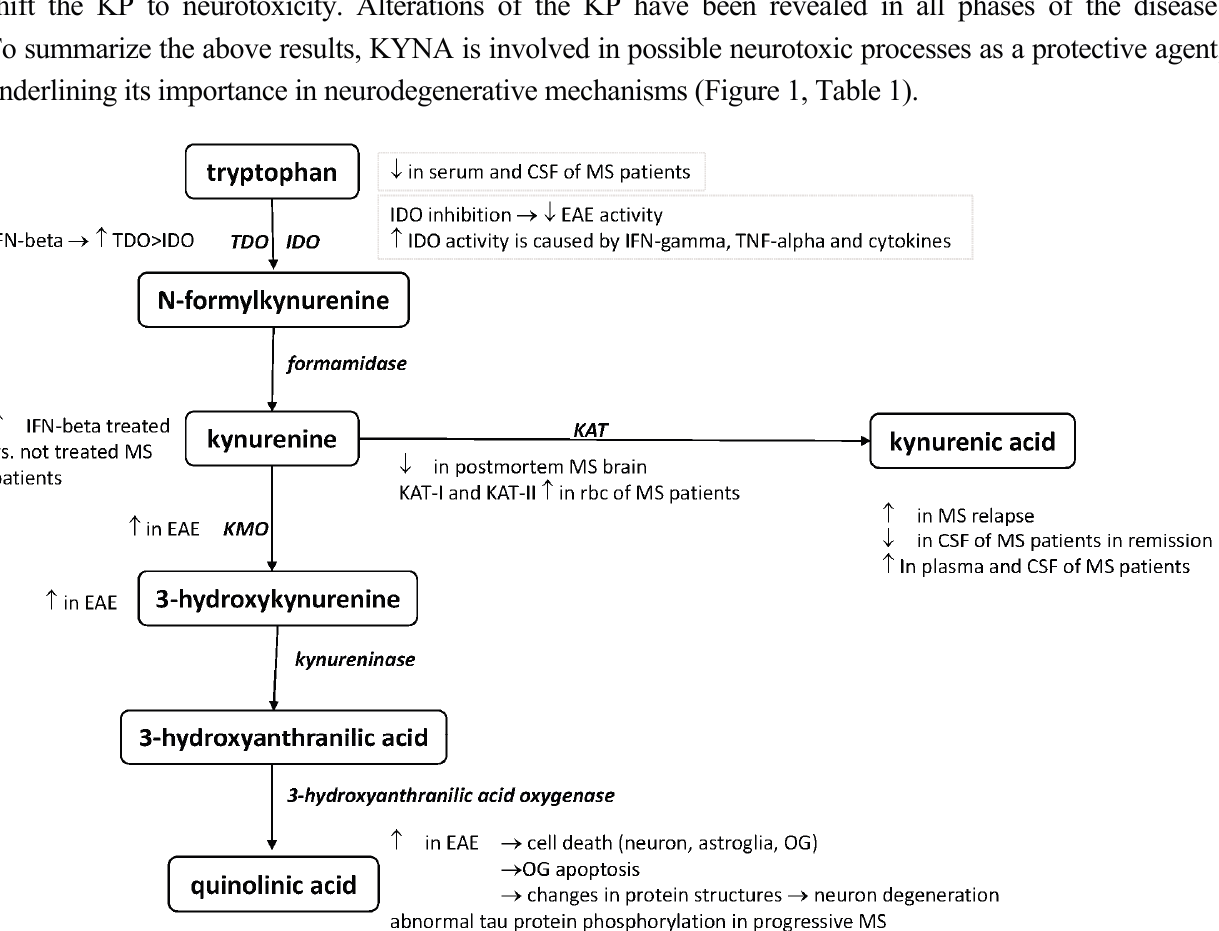
Figure 1. Alterations of the KP in EAE and MS. Alterations in the kynurenine pathway in EAE and MS—this schematic picture summarizes the alterations of the different kynurenine metabolites and enzymes in the animal model and human disease based on the presently published data. For list of abbreviations see page